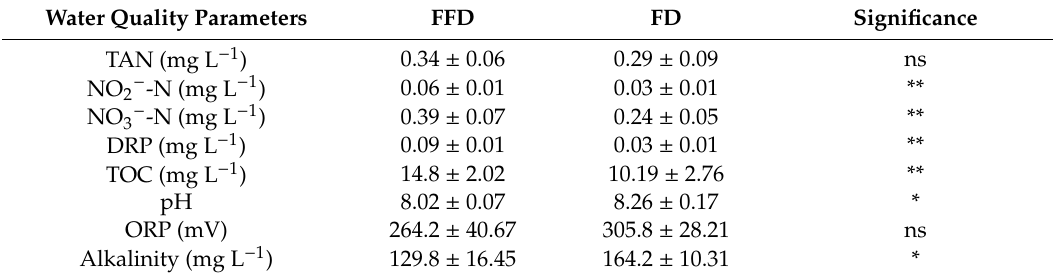
Table 1. The water quality parameters of water samples from two pond systems. Values are mean ± SD ( n = 15 samples treatment − 1 ). ** p < 0.01, * p < 0.05, ns: not